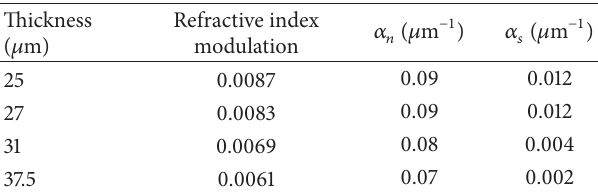
Table 3: Main parameters fitted from the angular response for chemical composition